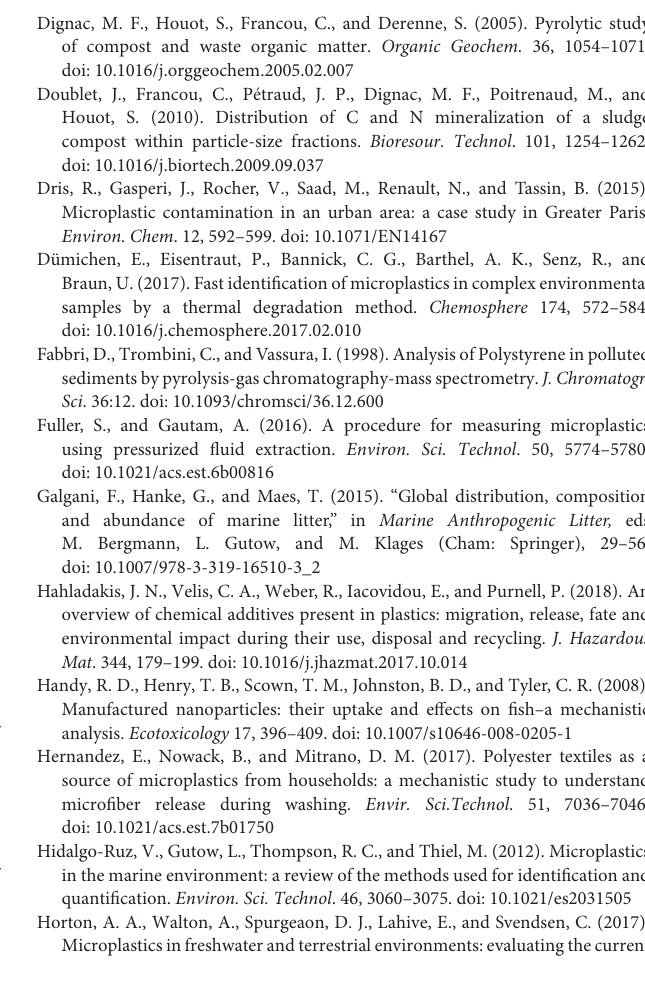
Figure S1 | Plastic contents (% dry matter) in the composts applied every year on the experimental field compared to the French thresholds for heavy and light plastics in composts set up in 2006 (NFU 44 051). Figure S2 | Fractionation scheme for isolating particle-size fractions of the compost (from Doublet et al., 2010). Figure S3 | . Nodule (1) and MPs observed in the compost. With view (2) as a whole view of individualized MPs corresponding to views (3–10) . Figure S4 | TEM views of < 2mm compost fractions, 5: 200–2,000 µ m fraction (1) , 50–200 µ m fraction (2, 3) ; < 50 µ m fraction (4) . cf, cellulosic fiber; cr, cell residue; cw, cell wall; ed, electron-dense MPs; h, hole due to resin disruption; mb, membrane structured MPs. Figure S5 | TEM views of the washed solutions recovered during the washing steps of the soil fractionation. 1 , aggregate of the centrifugated 20–50 µ m fraction; 2 , filtered 20–50 µ m fraction; 3 , centrifugated 2–20 µ m fraction; 4 , filtered 0–2 µ m fraction. b, bacteria; m, mineral; MPs, microplastic; om, organic matter; pr, plant residue; q,